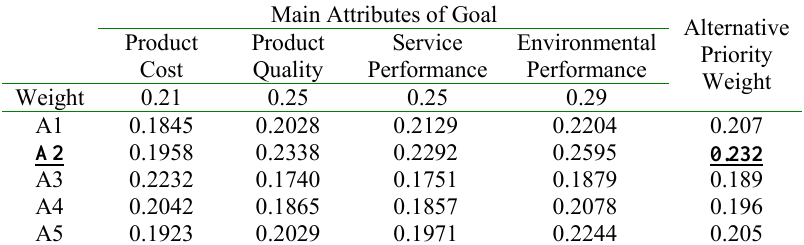
Table 23. Final ranking of the green supplier